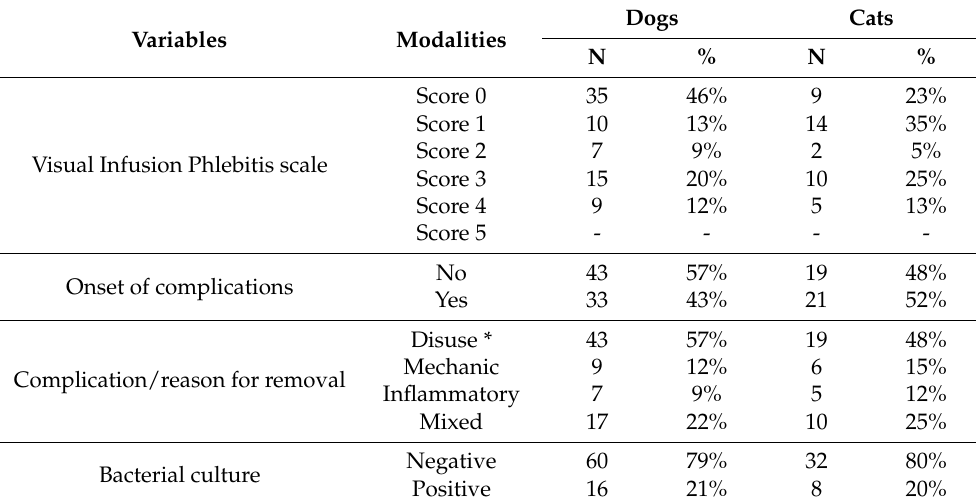
Table 4. Variables at the time of the catheter removal.